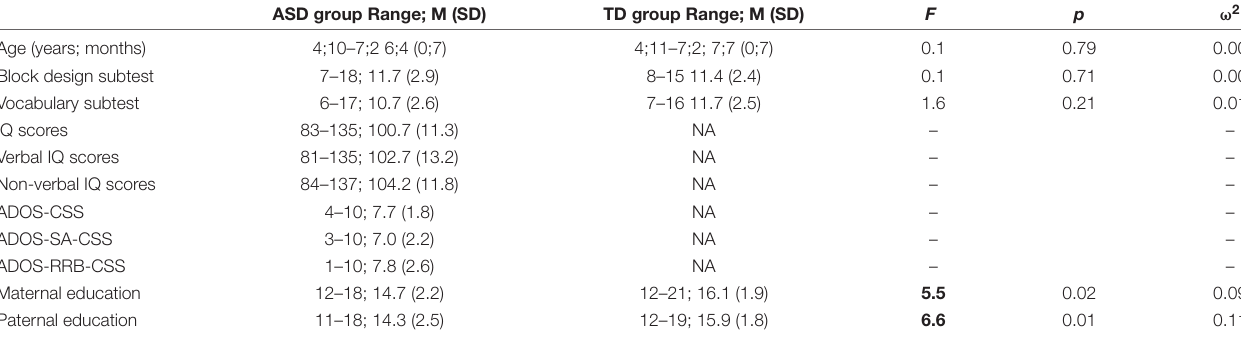
TABLE 1 | Characteristics of